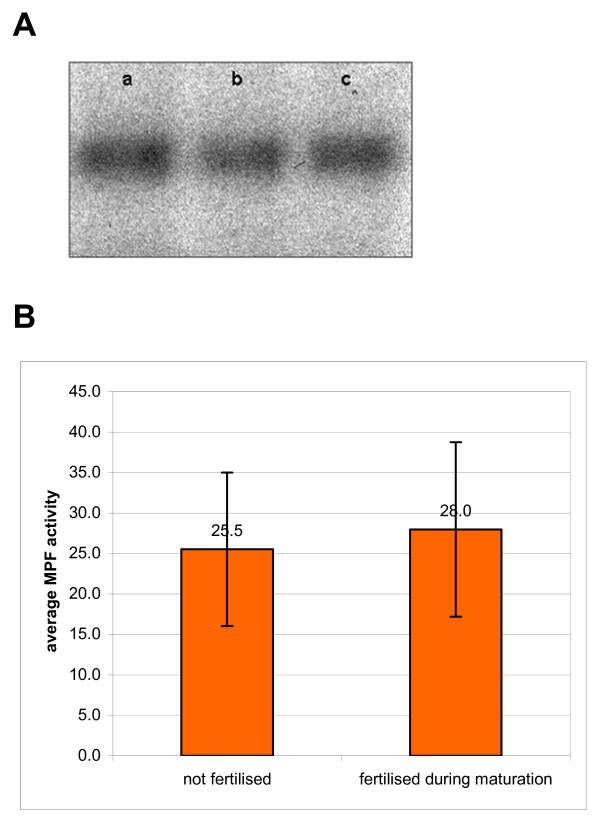
Histone H1 kinase activity in MII oocytes, which matured in vitro, and were fertilised during maturation, and in in vitro matured oocytes, which were not fertilised. (A) autoradiography showing the intensity of incorporation of [32P] into exogenous H1 histone in lysates prepared from MII oocytes. Each line corresponds to the activity prepared from 5 oocytes. (a) control, uninseminated oocytes, (b, c) oocytes, which were fertilised during maturation, 1 – 4 h after GVBD. (B) mean activity of histone H1 kinase in MII oocytes, which were fertilised during maturation and in MII oocytes, which were not fertilised. Differences between these two groups are not statistically significant (p > 0.05).